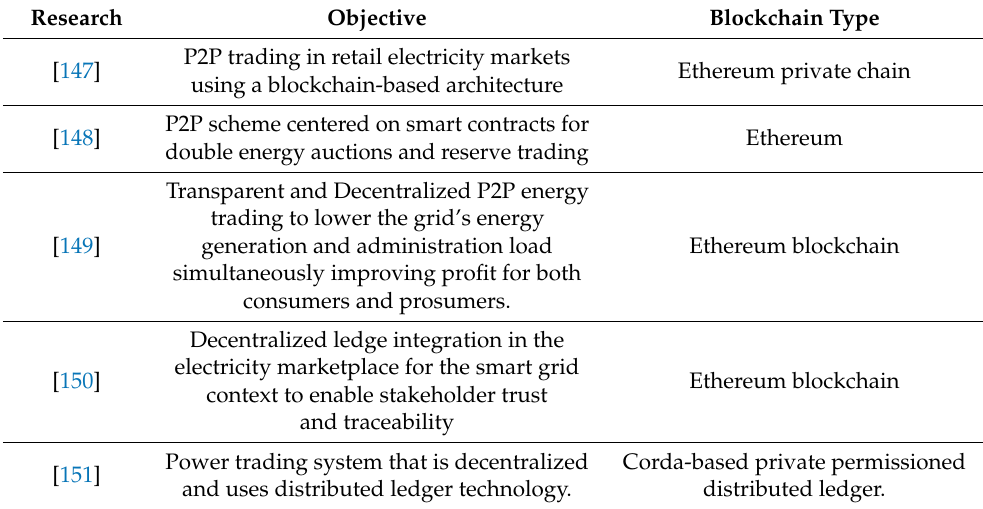
Table 3. Recent studies of Blockchain for energy trading.